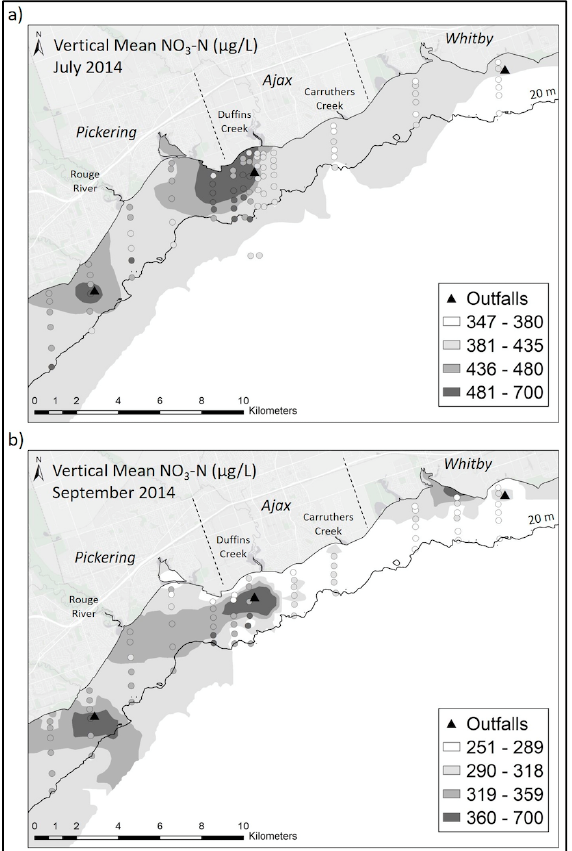
Figure 8. Spatial comparison of vertically averaged measured (circles) and modeled (filled contours) NO 3 -N concentration on ( a ) 19 July 2014 and on ( b ) 9 September 2014. Note: The modeled contours were produced using empirical Bayesian kriging (July) and ordinary kriging (September) interpolation methods in ArcMap and using vertically averaged model output at the sampling stations. To avoid extrapolation, contours were trimmed along the 36-m depth contour. Model results are from run#1.